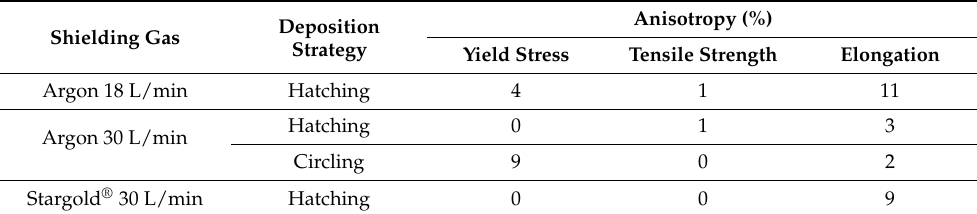
Figure 18. Mechanical properties of AA5356 with CMT. Table 6. Anisotropy percentage (%) values from the mechanical